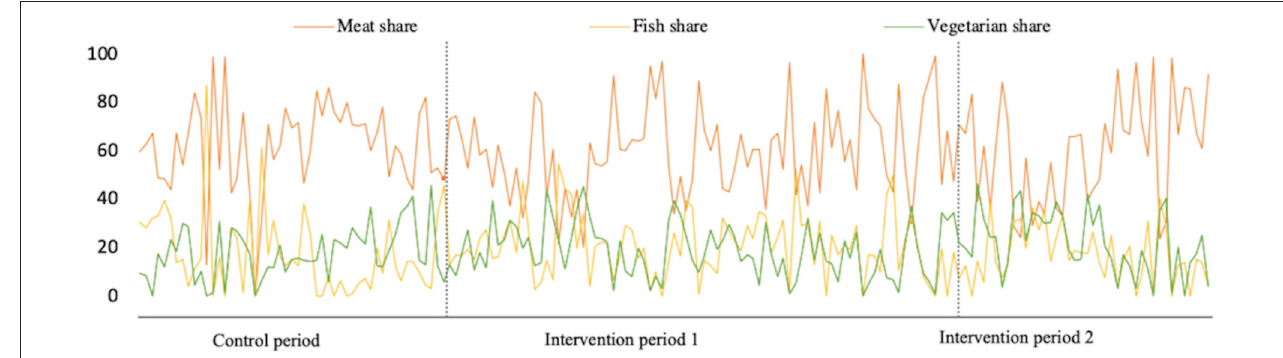
FIGURE 2 | Percentage share of different dishes of total sales during control period and intervention periods.